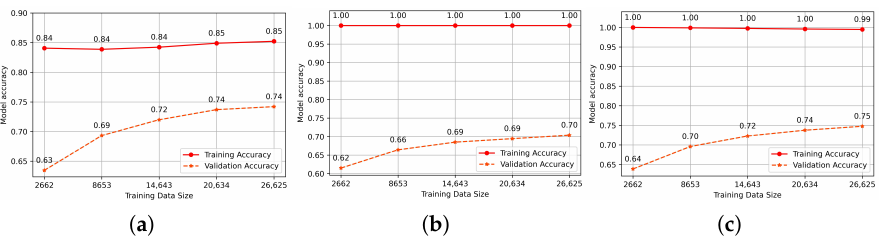
Figure 3. ( a ) SVM model learning curve, ( b ) KNN Model learning curve, ( c ) RF Model learning